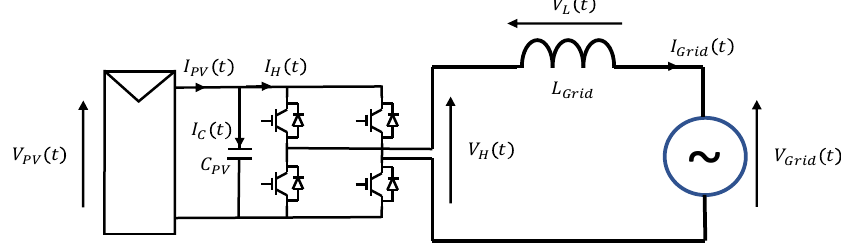
Figure 1. Configuration of the conventional H-Bridge grid-tied solar inverter.